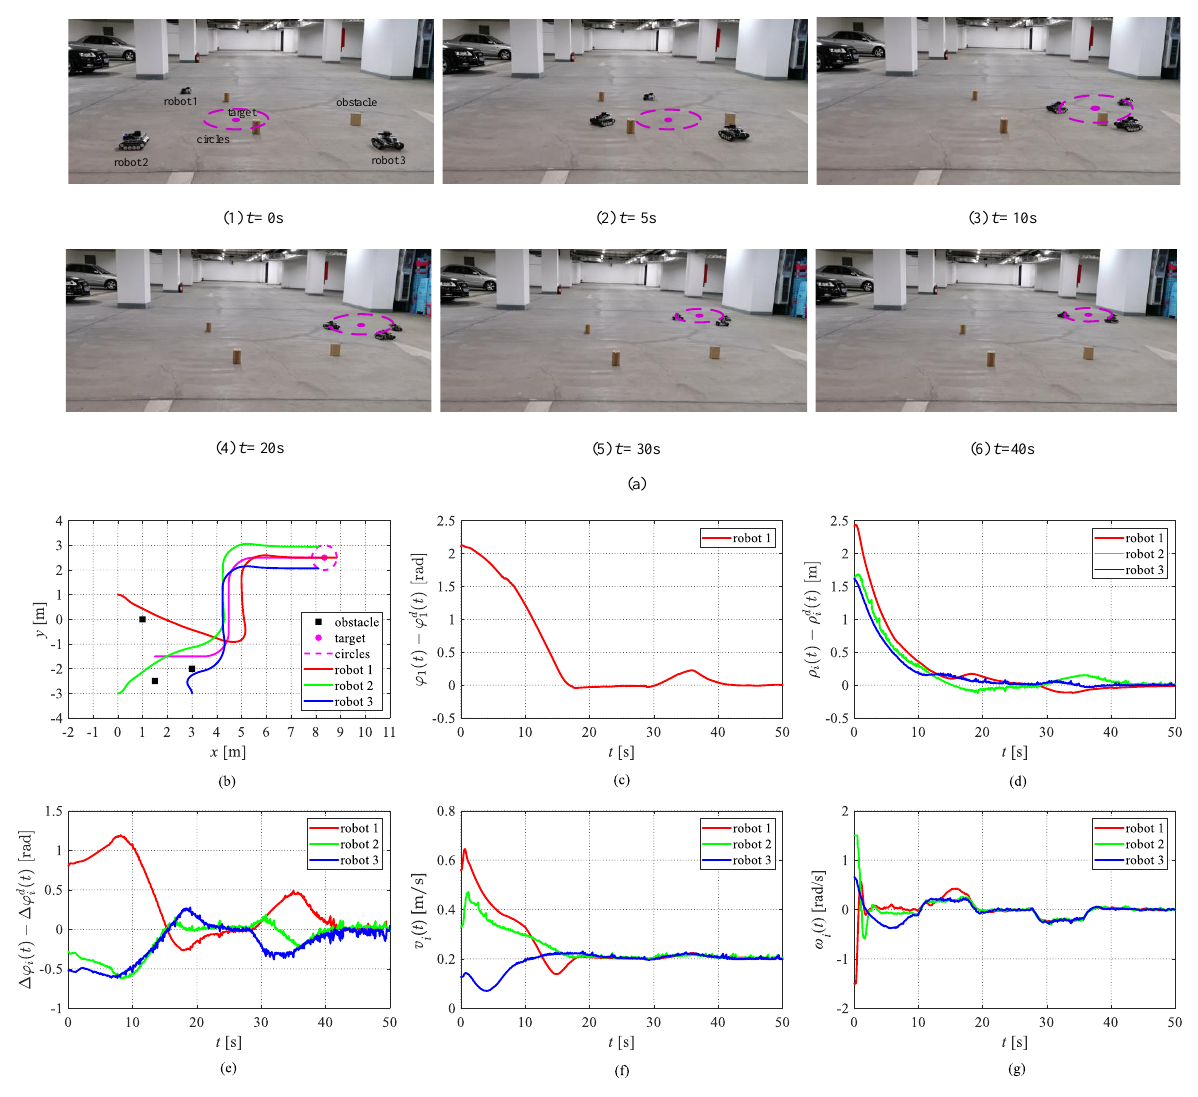
Figure 8. Experimental results of case 2. ( a ) The motion views of three nonholonomic mobile robots forming a evenly distributed circular formation with same circular radius to enclose and track a moving target with a constant speed. ( b ) Trajectories of the three robots and the target in the plane. ( c ) Error between current phase and the desired phase of robot 1. ( d ) Distance errors between the three robots and their desired circles centered on the target. ( e ) Errors between current angular spacing and the desired angular spacing of all adjacent inter-robots. ( f ) The linear speeds of the three robots. ( g ) The angular speeds of the three